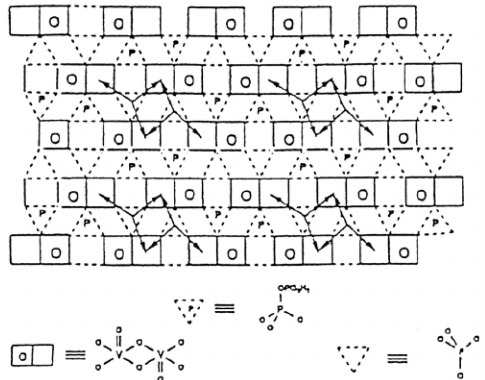
Figure 6. Schematic representation of a surface structure of a type of polytype of (VO) 2 P 2 O 7 . The arrows represent the facile pathways for surface oxygen mobility. This illustrates the site isolation principle by surface P 2 O 7 groups which constitute a barrier to oxygen diffusion. Reproduced from [8] Copyright 2016, Elsevier